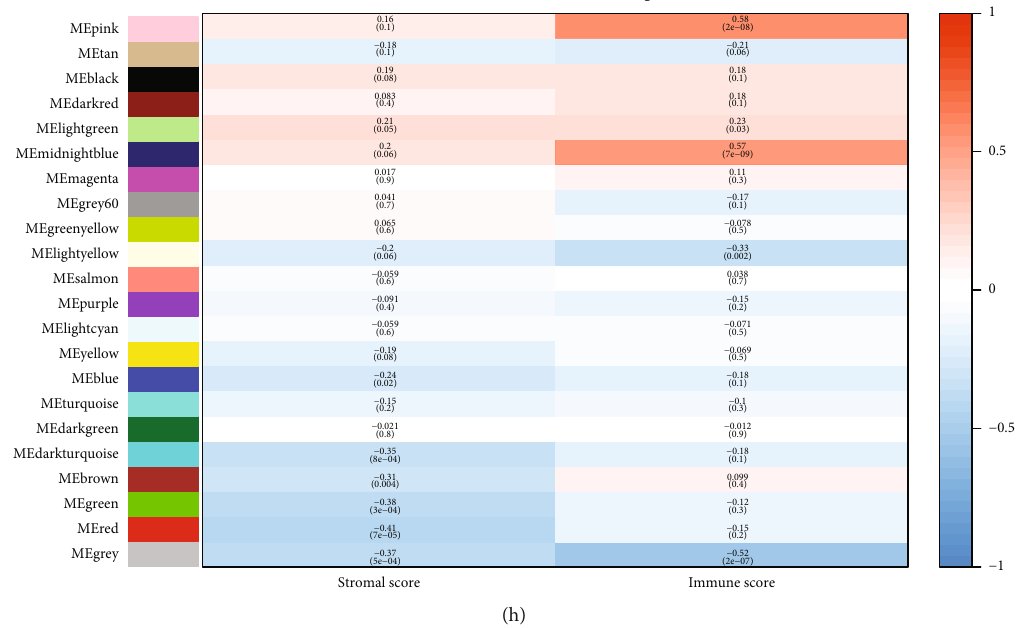
Figure 3: The samples clustering dendrogram, immune score, stromal score, and the determination of soft-thresholding power analyzed by WGCNA. (a) Sample clustering was performed to detect outlying samples based on immune score and stromal score. The red line indicates the cut-o ff point for data fi ltering in the data preprocessing step. (b) Clustering based on incorporating immune scores and stromal scores of expression data from osteosarcomas with clinical data and color intensity is proportional to immune and stromal scores. (c) Analysis of the scale-free fi t index for various soft-thresholding powers ( β ). (d) Analysis of the mean connectivity for various soft-thresholding powers. (e) Clustering dendrogram of genes based on a dissimilarity measure (1-TOM). (f) Pink coexpression modules based on immune scores yielded scatter plots of gene signi fi cance (GS) versus module membership (MM). The screening conditions were the correlation between genes, and the pink module was more signi fi cant than 0.8, and the correlation coe ffi cient between genes and the immune score was greater than 0.5. (g) The DEG PPI network module analysis via Cytoscape software. (h) Heatmap of the association with MES and immune score and stromal score of OS. OS: osteosarcoma; TOM: topological overlap stromal; MES: module eigengenes; PPI: protein-protein interaction; DEGs: di ff erentially expressed